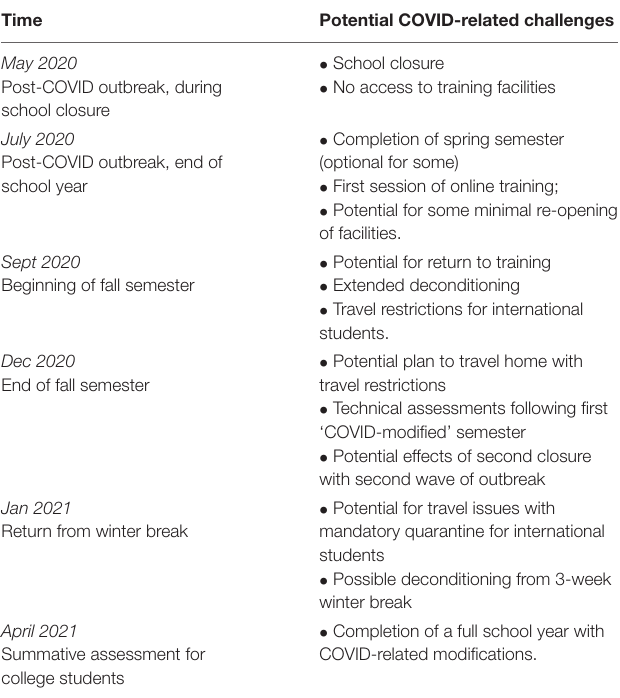
TABLE 1 | Rationale for post-COVID data collection